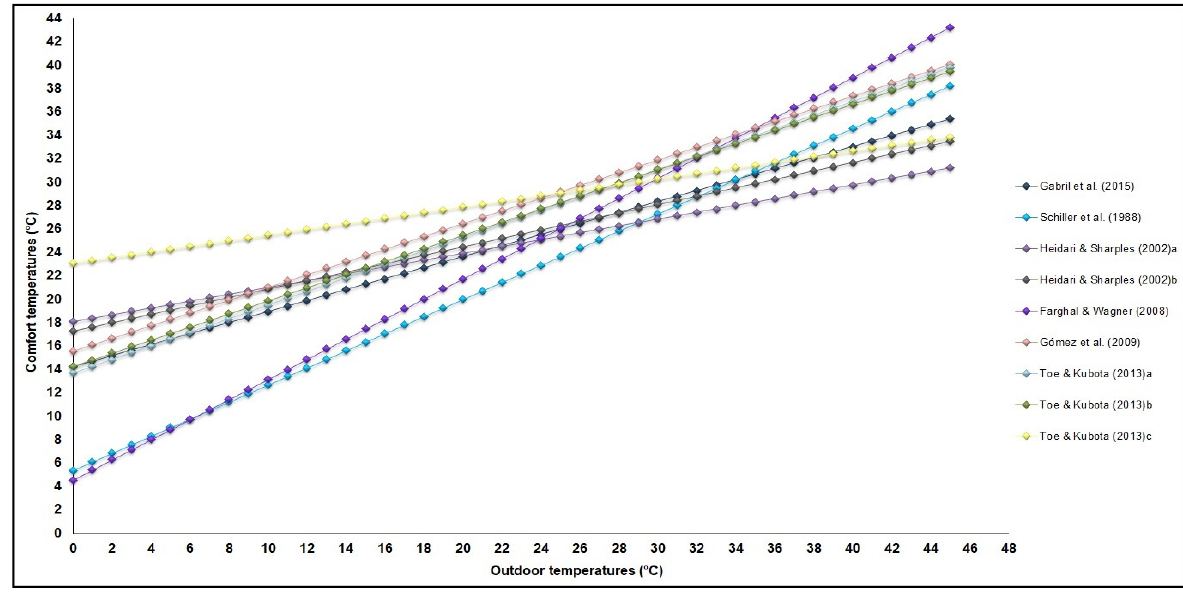
Figure 3. ( a , upper ) Linear models of comfort temperatures vs. outdoor temperatures for hot-humid climates according to Table 1. ( b , lower ) Distribution of event probabilities divided into regions. The rectangles include the number of lines that pass through a specific region. The color codes represent the number of events: green = 1–3, yellow = 4–6, brown = 7–9 and red > 10. The colors were used to denote in each box the incidence of the regression lines of the thermal comfort models reported in Tables 1 and 2; for example, when one to three lines (linear equations) coincide in a region, the color green is used in the plane; when more than 10 straight lines coincide, the color red is used. The coincidences of these models in the plane are also observed in Figures 3b and 4b. These incidence graphs made it possible to detect the regions in the plane in which the thermal comfort models developed under different conditions can coincide.